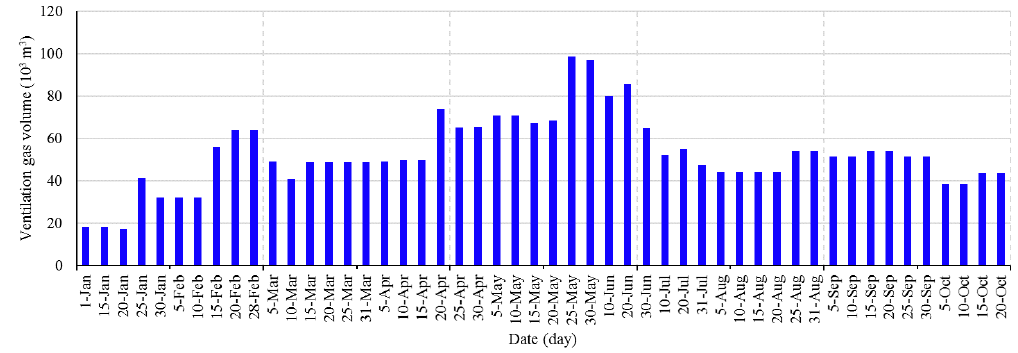
Figure 13. Ventilation gas volume statistics.